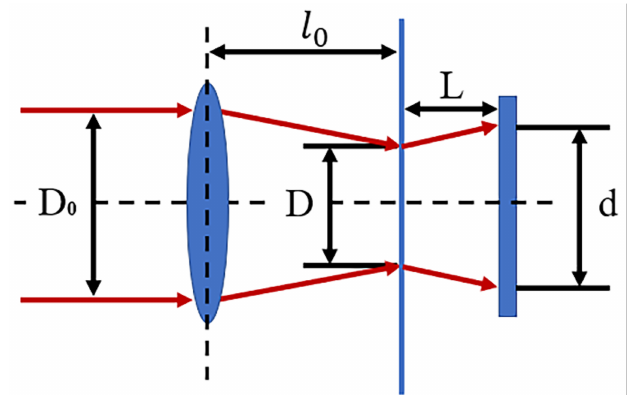
Figure 5. Defocus and spot size light path diagram. (D 0 : Incident laser beam diameter, D: Beam spot diameter, d: The laser beam actually acts on the sample spot diameter, L: Defocus, l 0 : Focal